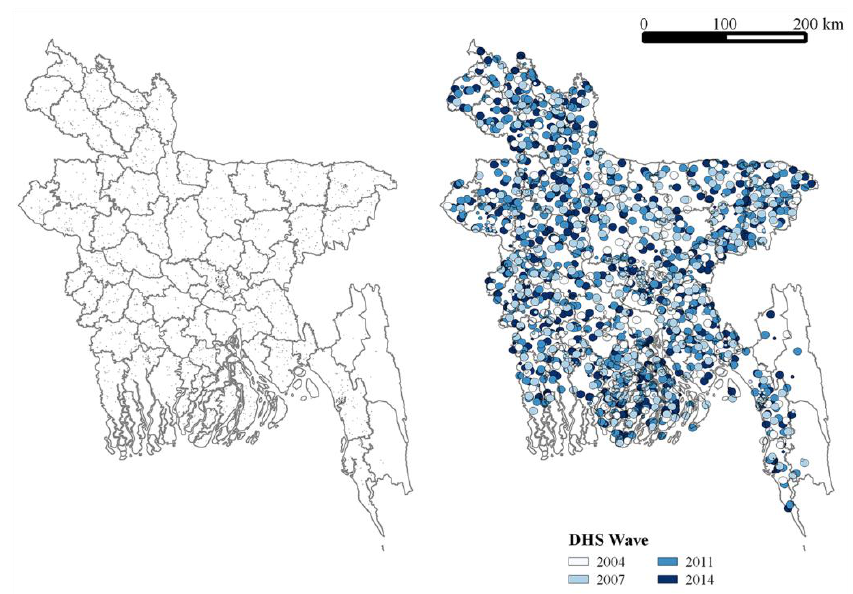
Figure 1. The point location (left) and buffer zone (right) of each Demographic and Health Survey (DHS) cluster on a district map of Bangladesh. The radius of the buffer zone is 5 km for a rural cluster and 2 km for an urban cluster. The color of the buffer zone indicates the DHS wave during which it was surveyed.